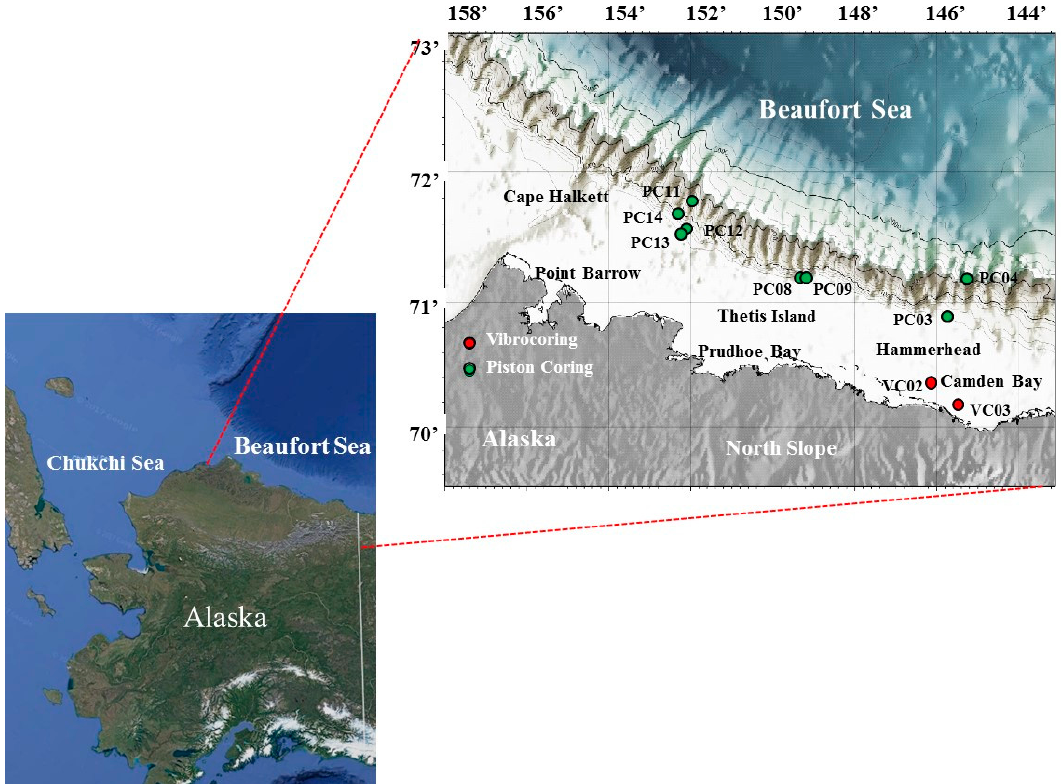
Figure 1. Map showing study area and piston core (PC) and vibrocore (VC) locations along three nearshore-to-offshore transects (from east-to-west: Hammerhead, Thetis Island, Cape Halkett) across the Alaskan Beaufort Sea shelf during the 2009 Methane in the Arctic Shelf/Slope (MITAS) expedition.